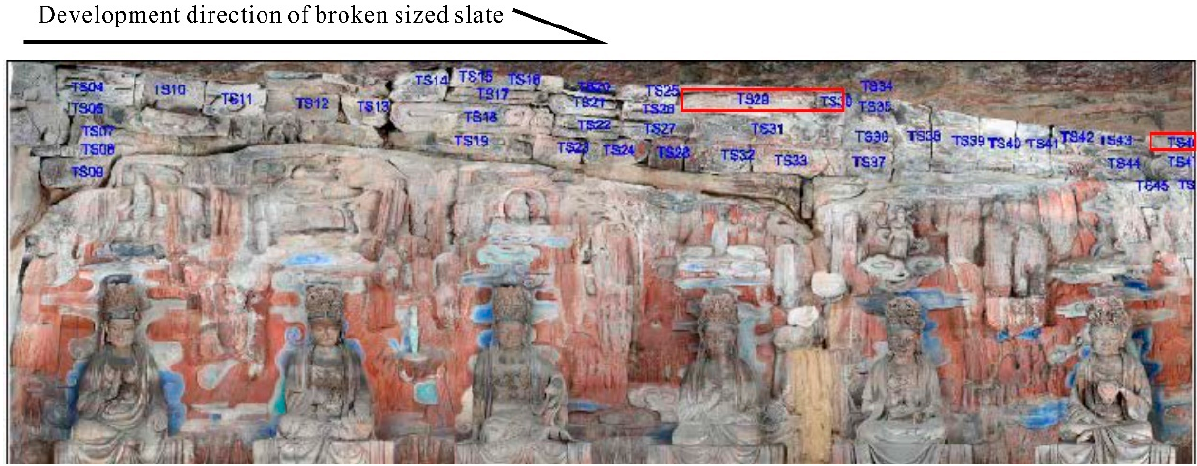
Figure 15. Characteristic points of broken slates and destabilization warning points